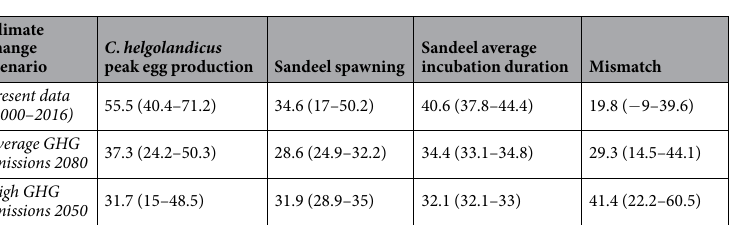
Table 3. Comparisons of peak egg production in C . helgolandicus , spawning day and embryonic development in sandeel and the resulting trophic mismatch in present temperature conditions or predicted according to modelled future climate projections. Numbers in brackets correspond to 95%